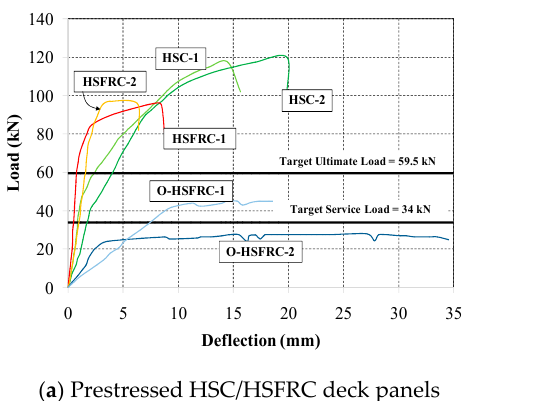
Figure 7. Load deflection responses of prestressed deck panels.